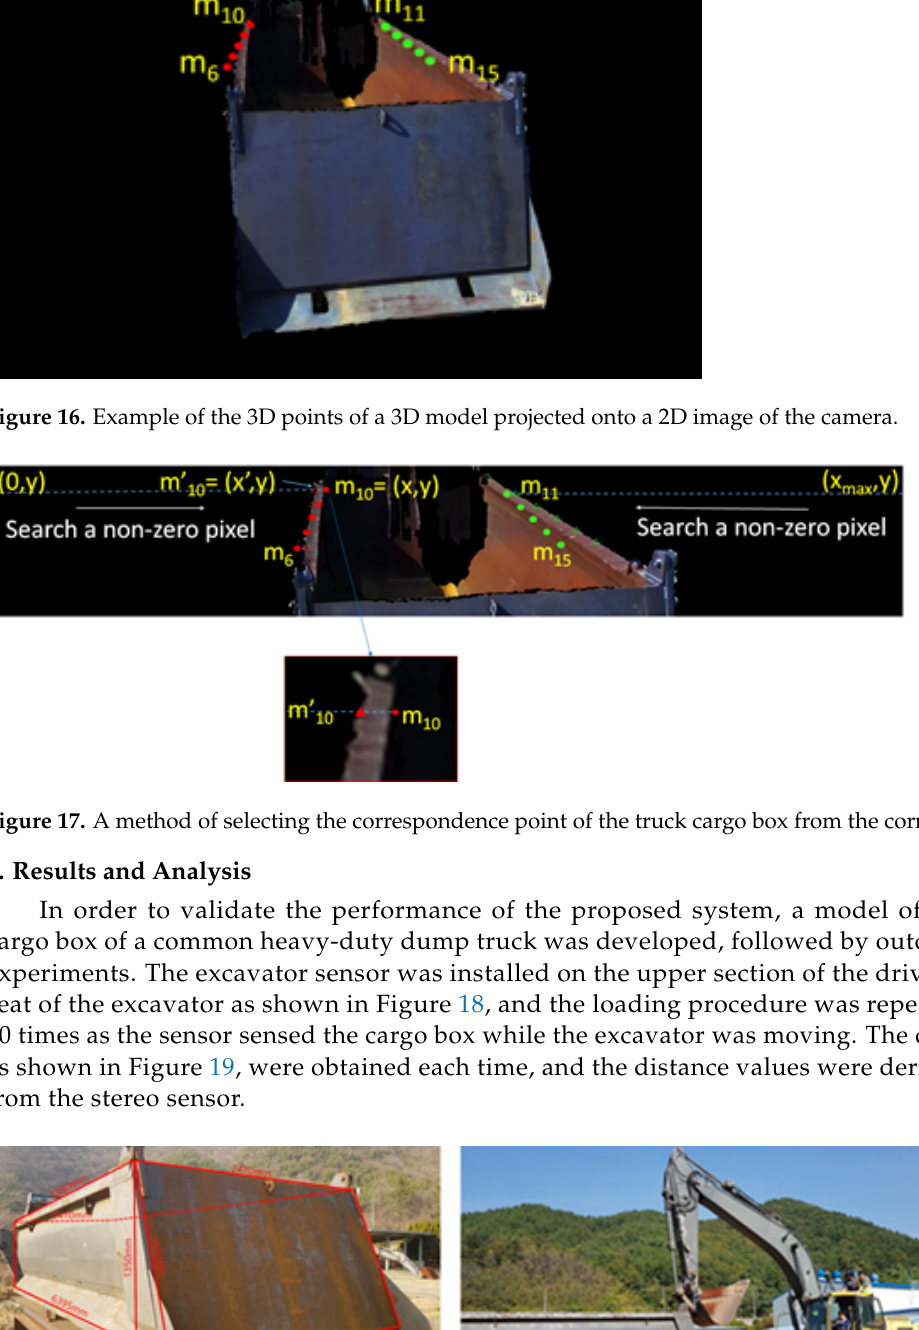
Figure 15. Example of 5 3D points sampled for each corner along the long axis of a cargo box.